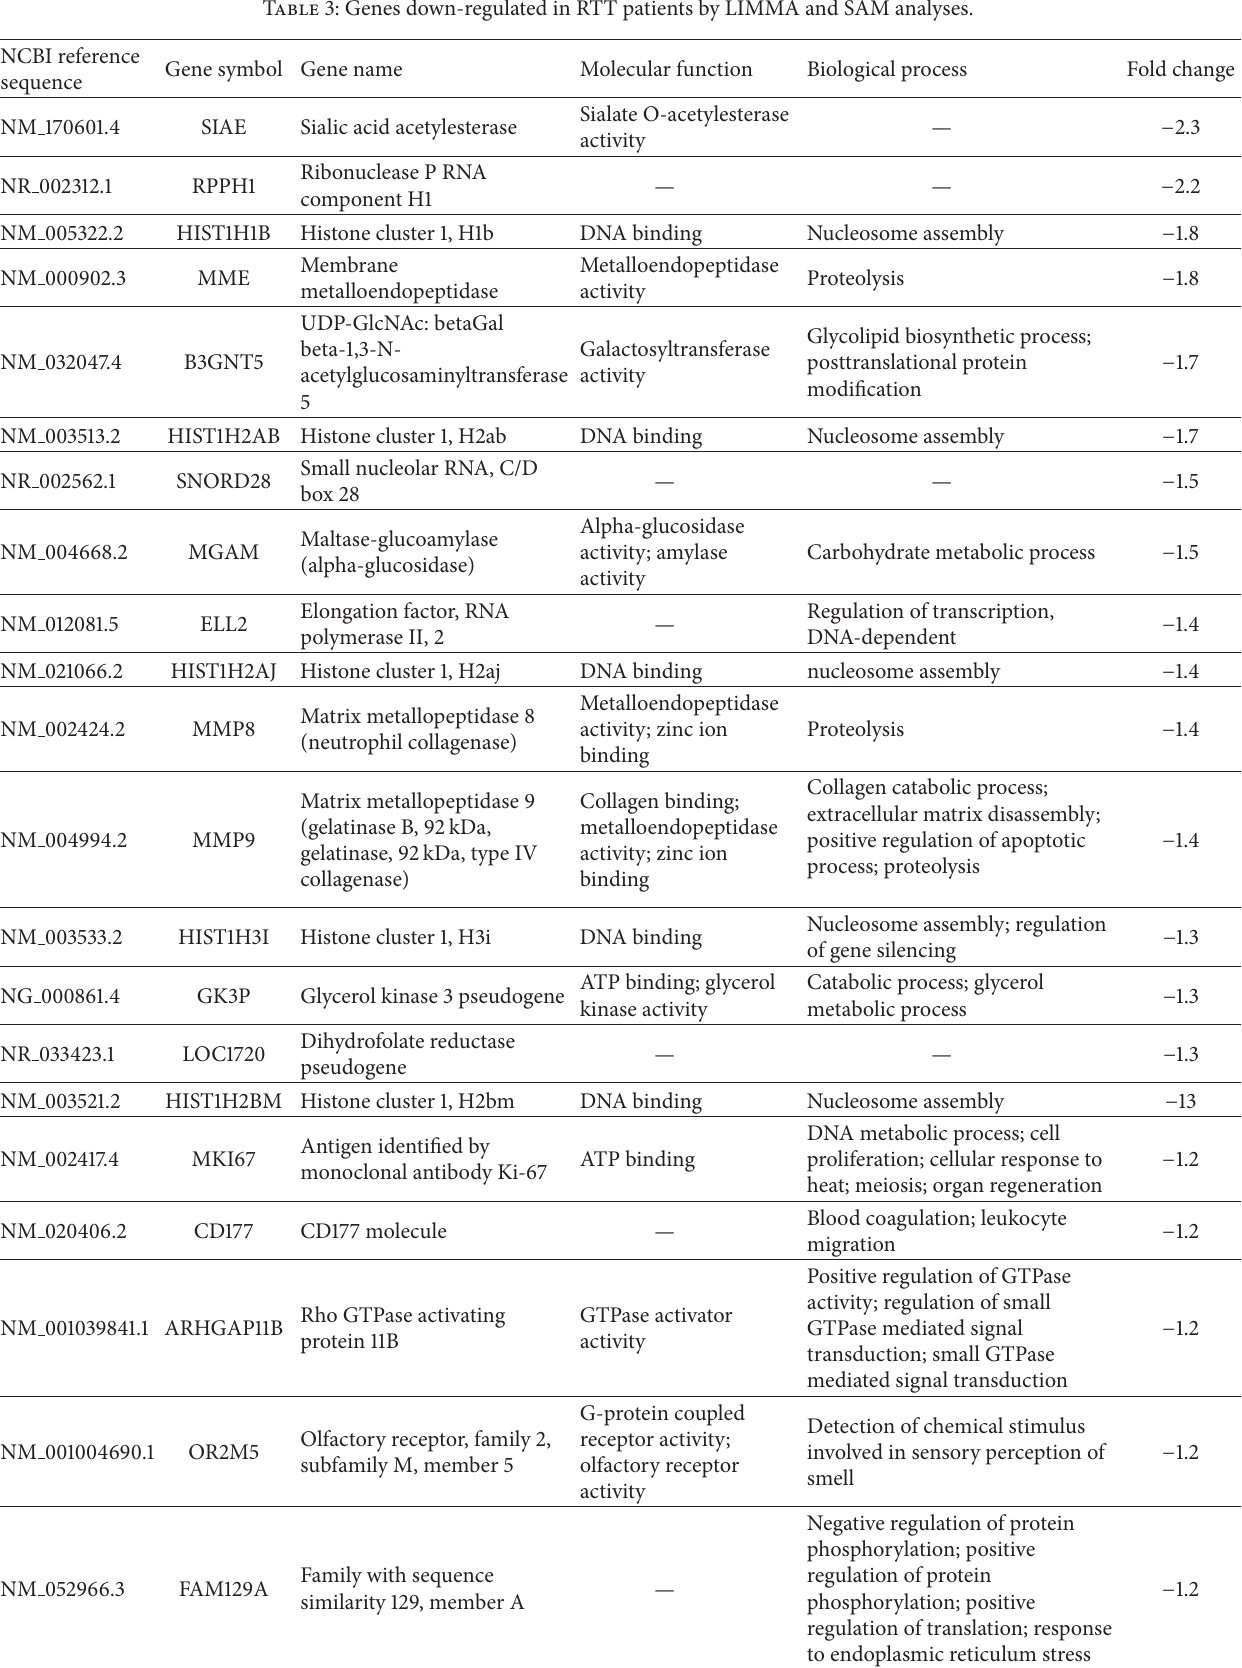
Table 3: Genes down-regulated in RTT patients by LIMMA and SAM